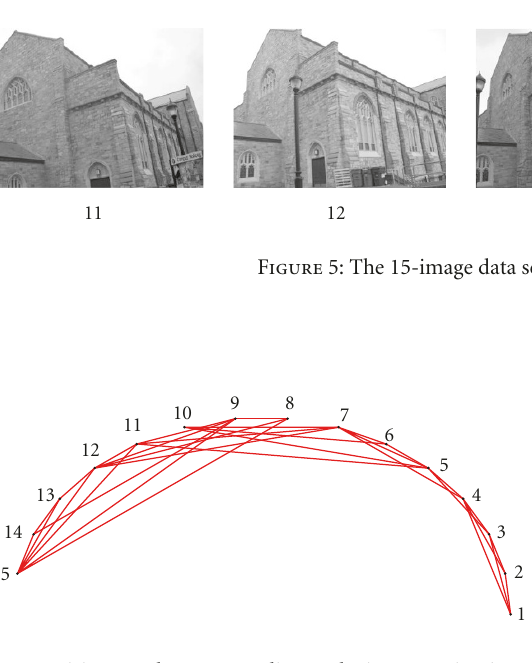
Figure 6: Vision graph corresponding to the image set in Figure 5.